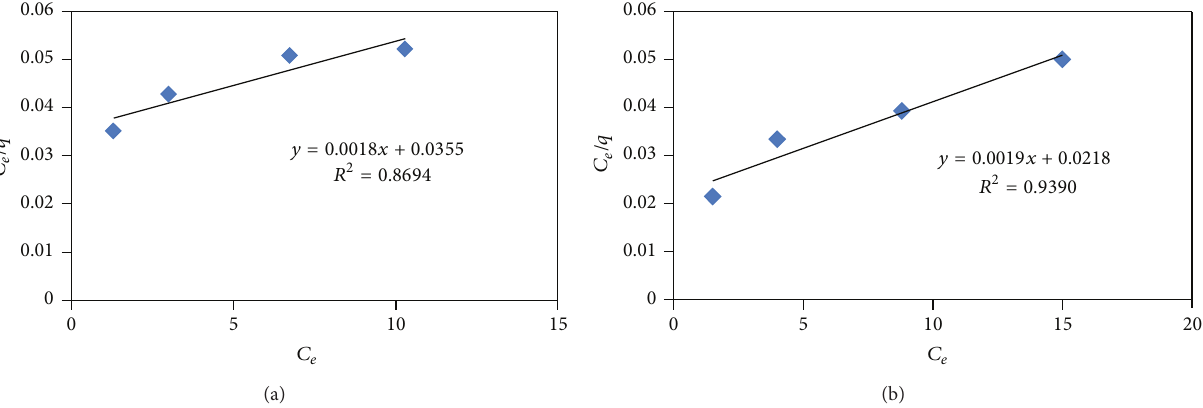
Figure 13: (a) Langmuir isotherm of basic orange dye adsorption onto CNTs (pH = 8.5, CNTs = 100mg/L, contact time = 30 min). (b)